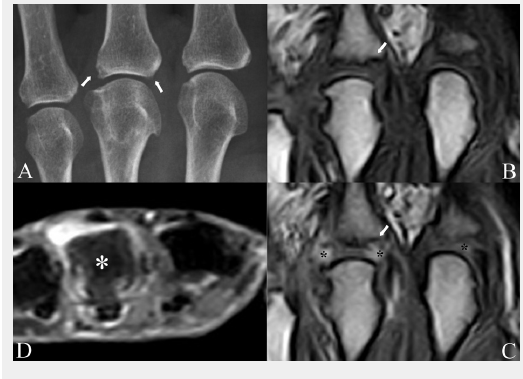
Conventional radiography and MRI study of the metacarpophalangeal joints of a patient with undifferentiated oligoarthritis lasting from less than 6 months. A) the radiogram shows degenerative changes (osteophytes) of the 3 rd metacarpophalangeal head and small erosions (arrows) of the proximal end of the corresponding phalanx. The erosion on the right is only suspected because of an interrupted bony cortex; pre (B) and post-contrast (C) coronal Turbo 3D MRI sequences showing synovial enhancement of the painful 3 rd metacarpophalangeal joint (asterisks) and confirmation of the suspected erosion (arrow). Inflammation is present also in the asymptomatic and clinically normal 2 nd metacarpophalangeal joint (asterisk). Axial STIR MRI sequence (D) showing intense bone marrow oedema of the 3 rd metacarpal head (asterisk), which appears gray in comparison with the normal bone of the other metacarpals, which appears black. All MRI images are obtained with an extremity-dedicated 0.2 T machine (Esaote, Genova,